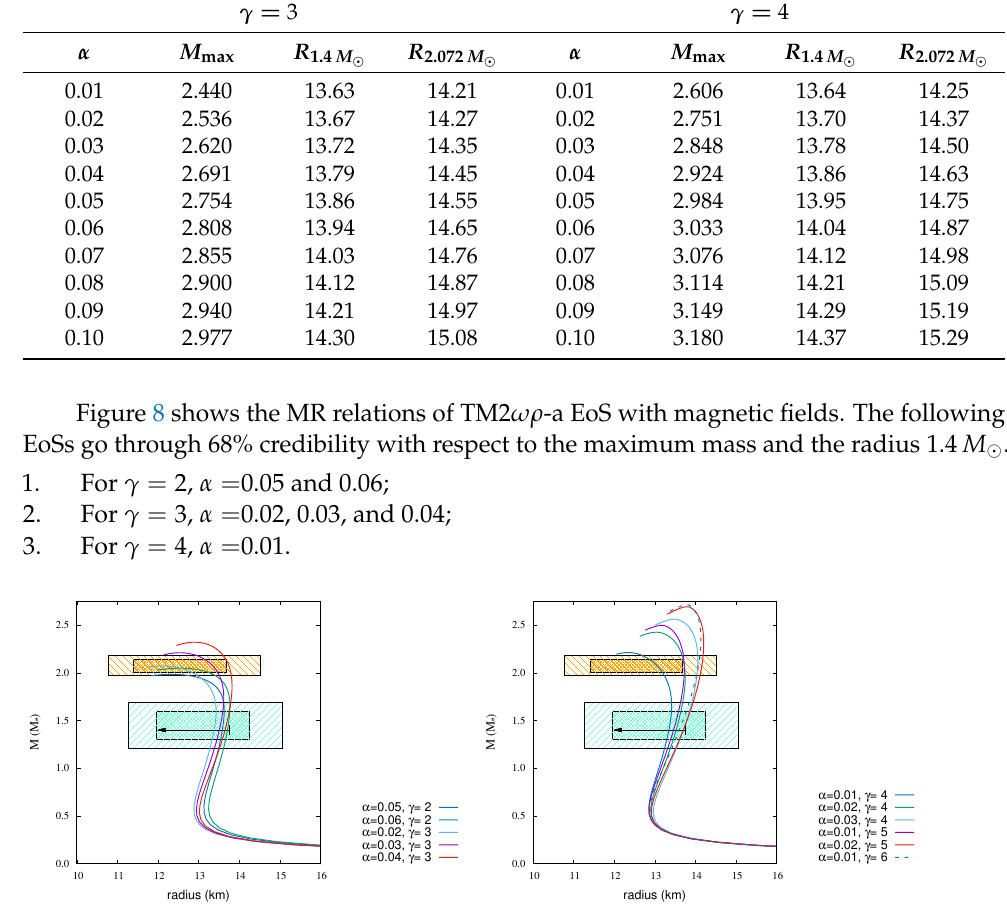
Figure 8. MR relations of TM2 ωρ -a EoS with magnetic fields. The strength of surface magnetic field strength B s is 10 12 G, and the central magnetic field strength B 0 is 2.5 × 10 18 G. The arrow and colored hatched areas are the same as in Figure